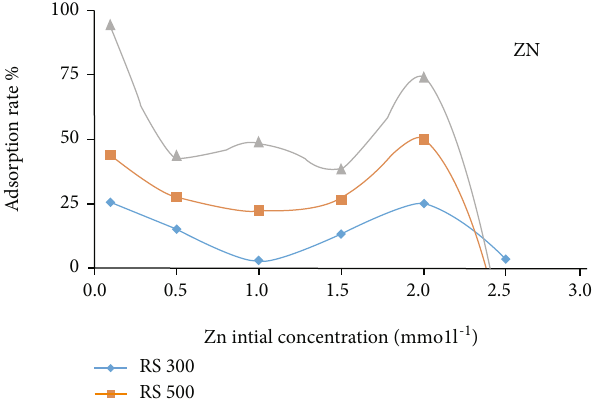
Figure 12: Adsorption of Zn 2+ at di ff erent concentrations of heavy metal ions in mixed working fl